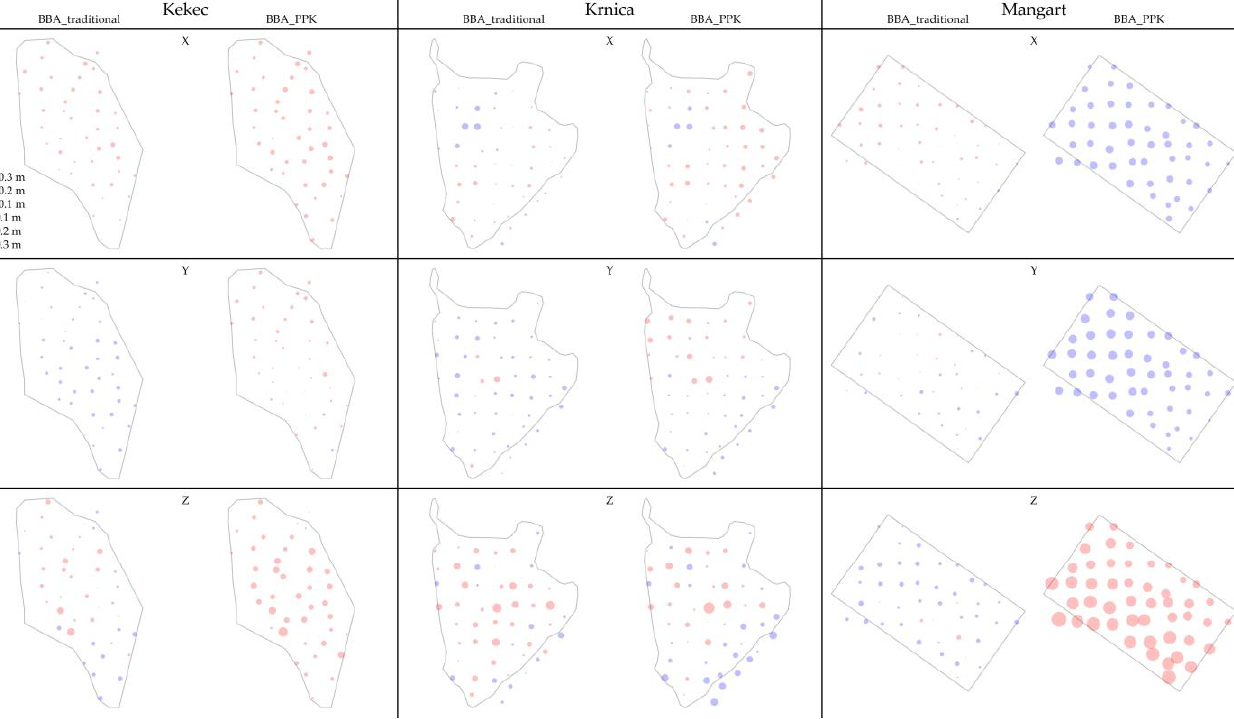
Figure 10. Spatial distribution of the differences in X and Y coordinates, calculated for accuracy assessment of orthomosaic produced by the BBA_traditional and the BBA_PPK method, and of the differences in Z coordinates, calculated for accuracy assessment of DSM produced by the BBA_traditional method and the BBA_PPK method.